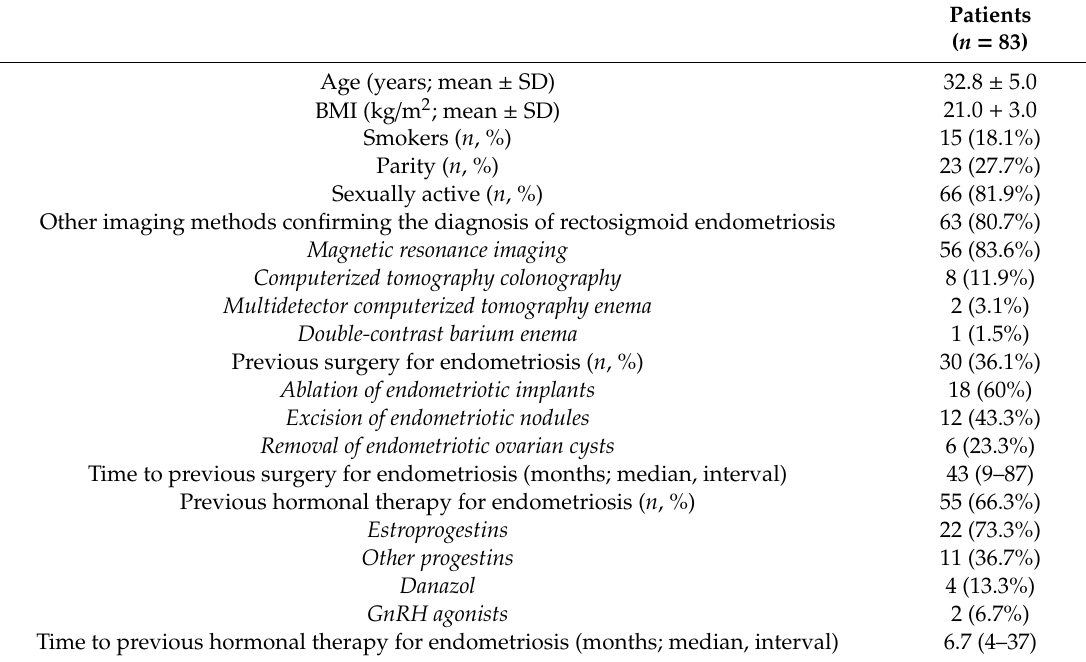
Table 1. Demographic characteristics of the patients included in the